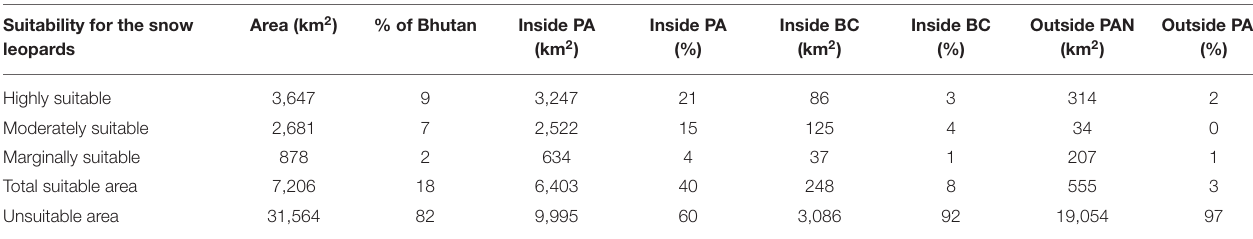
TABLE 1 | Suitable and unsuitable habitats for snow leopards in Bhutan inside and outside the protected areas network (PAN). Suitability for the snow